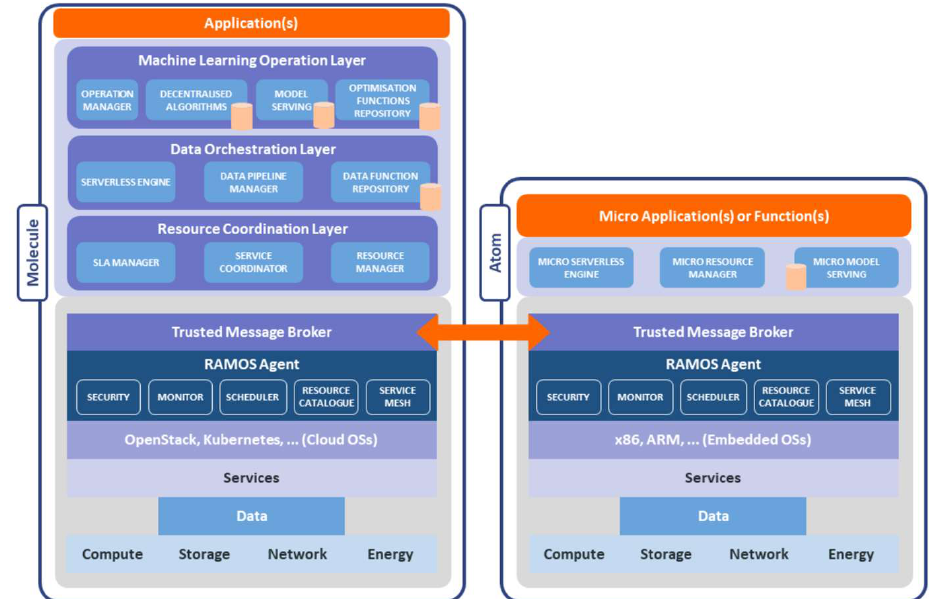
Figure 3. Detailed layered architecture of Atoms and Molecules at